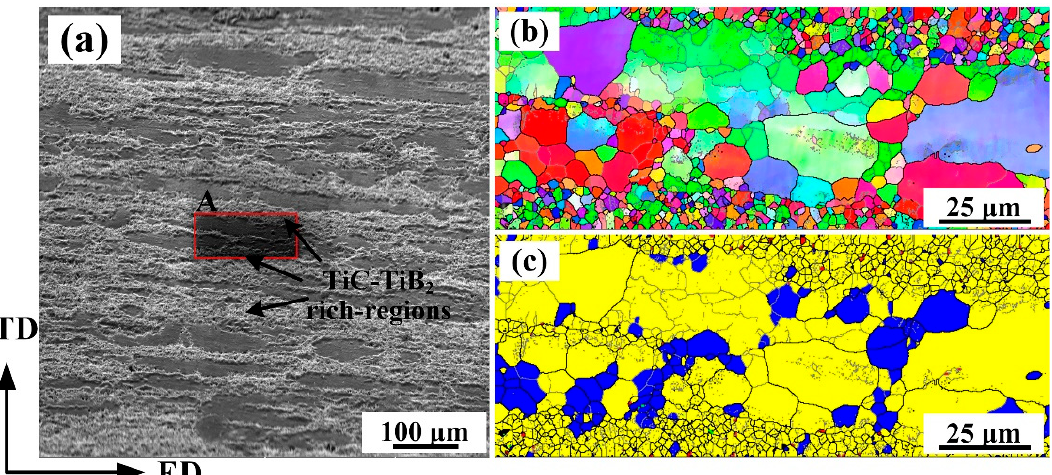
Figure 5. ( a ) SEM image, ( b ) inverse pole figure (IPF) image and ( c ) recrystallized microstructure EBSD image of the extruded 10 wt.% (TiC-TiB 2 )/Al-4.7Cu-0.32Mg-0.44Si composite after T6 heat treatment. The tensile mechanical properties, hardness and actual density of the Al-4.7Cu-0.32Mg- 0.44Si alloy and in situ (TiC-TiB 2 )/Al-4.7Cu-0.32Mg-0.44Si composites are presented